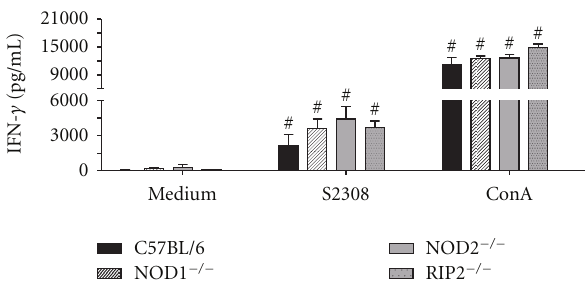
Figure 2: IFN- γ production by spleen cells induced by B. abortus in NOD1, NOD2, and Rip2 KO mice. C57BL/6, NOD1 − / − , NOD2 − / − , and RIP2 − / − mice were infected with 10 6 CFU of B. abortus S2308, and 2 weeks after infection, spleen cells (1 × 10 6 /well) were stimulated with B. abortus S2308 (MOI 100 :1) or concanavalin A (5 μ g/mL). Supernatants were harvested after 72h for measuring IFN- γ levels by ELISA. Statistically significant di ff erence in relation to nonstimulated cells is denoted with #. The significance of di ff erences was compared by ANOVA followed by Tukey’s test ( P < 0 . 01).